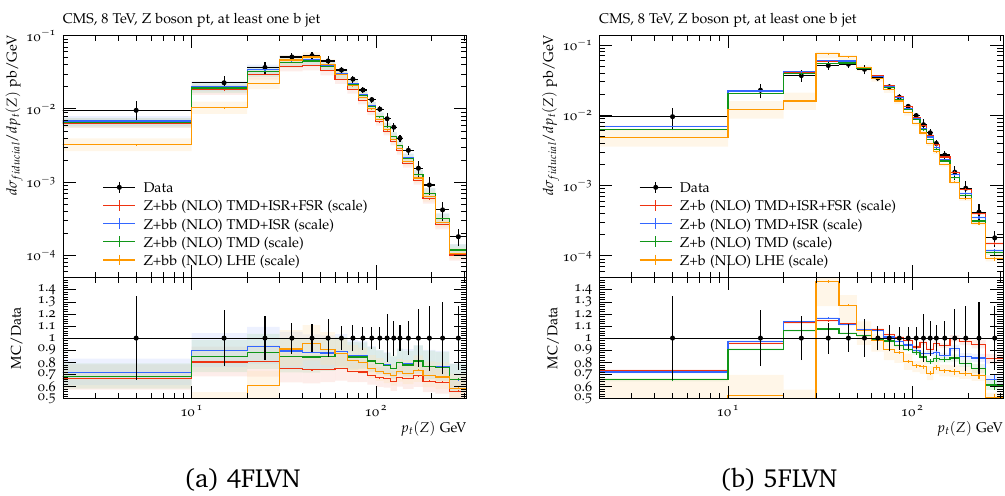
Figure 2: Differential cross section for Z + b¯b tagged jets as a function of the transverse momentum of the Z-boson as measured by CMS [ 10 ] at prediction is shown in (a), the 5FLVN-prediction in (b). The LHE files (parton level), after inclusion of PB-TMDs, initial state parton shower and final state parton shower are illustrated separately.